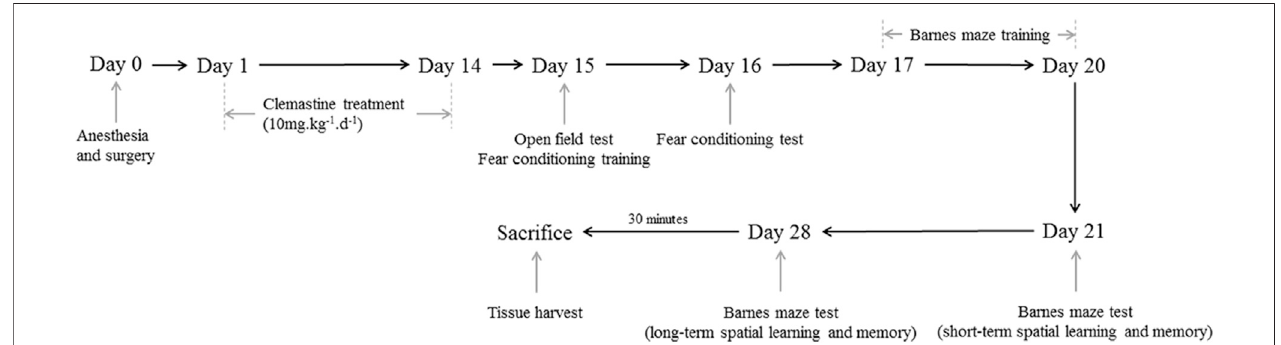
FIGURE 1 | Diagram of timeline of experimental